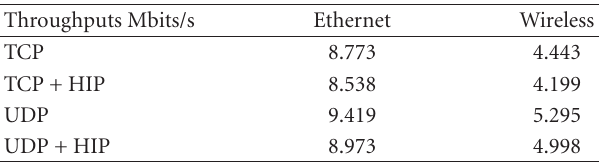
Figure 5: Test Scenario B results—RTT measurements (millisec- onds). Table 7: Scenario C test results-throughputs (Mb/s). Throughputs Mbits/s Ethernet